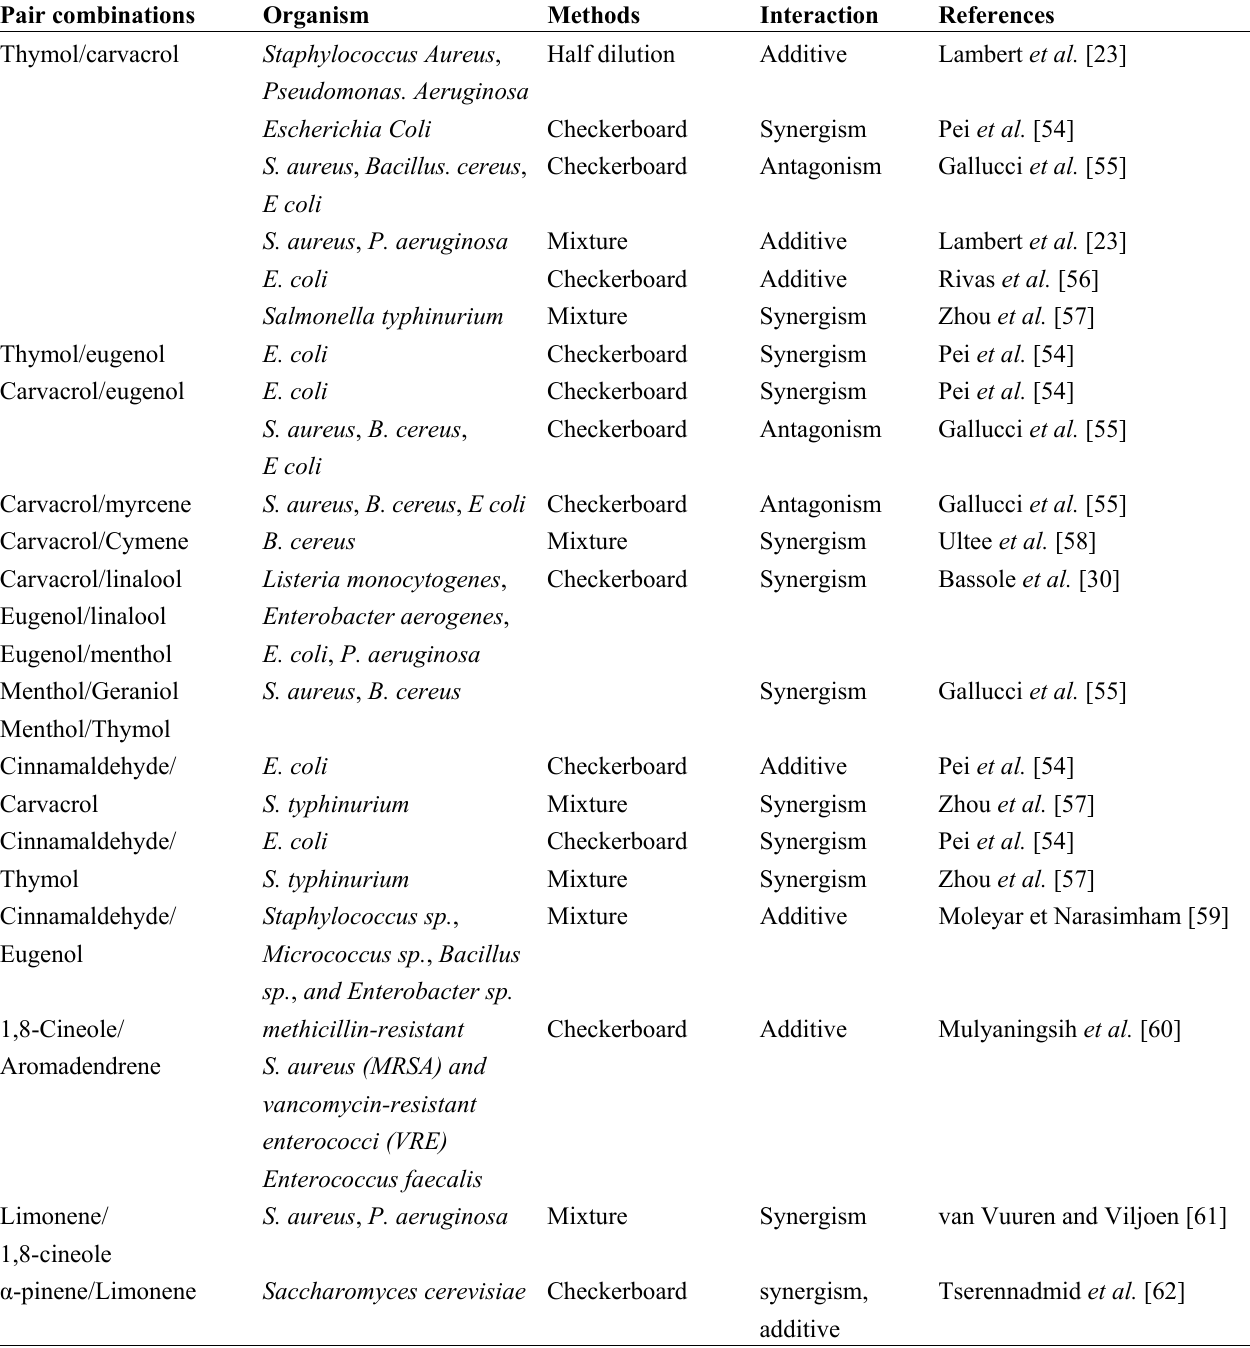
Table 1. Combination of components and essential oils and their antimicrobial interactions against several